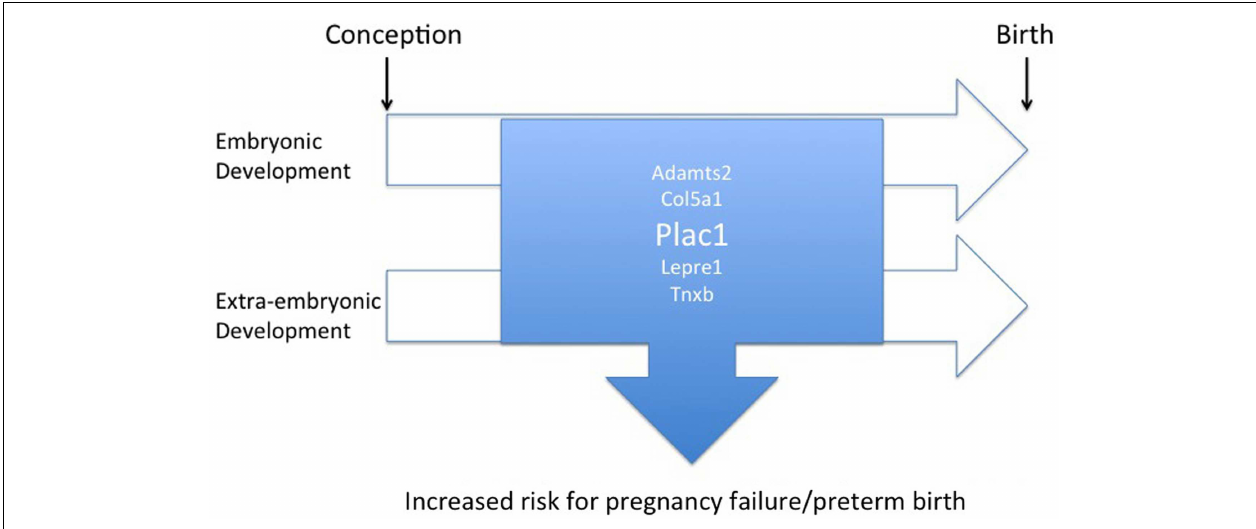
FIGURE 1 | Diagram illustrating the overlap of regulatory pathways involved with placental and embryonic development that, when disrupted, may contribute to an increased risk of preterm birth or miscarriage as well as birth defects .